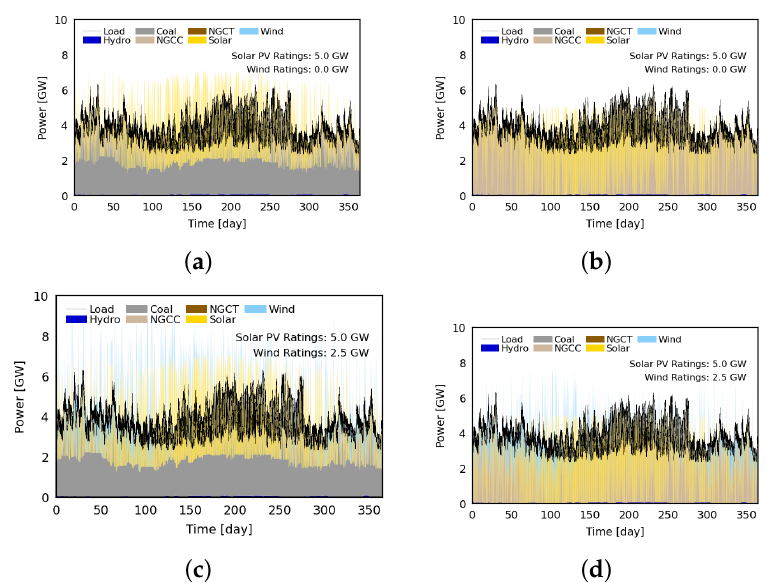
Figure 5. Full year minutely simulation of optimal power dispatch for 4 decarbonization scenarios: ( a ) C S ; ( b ) NG S ; ( c ) C SW ; and ( d ) NG SW . Compared to natural gas at the same solar PV ratings, coal-dominant cases suffer from a significant under-utilization of available VRE